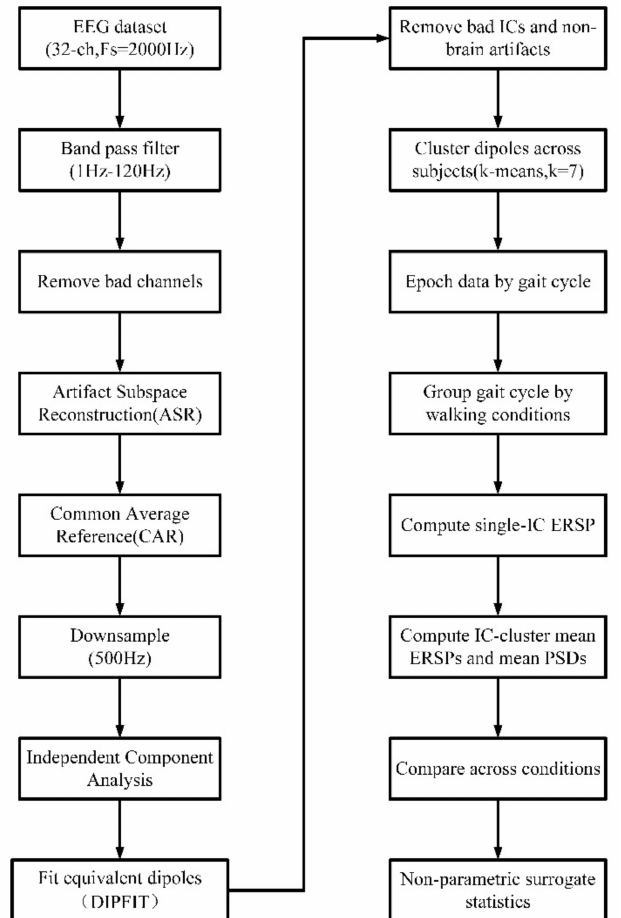
Figure 2. Flow-chart of the EEG processing